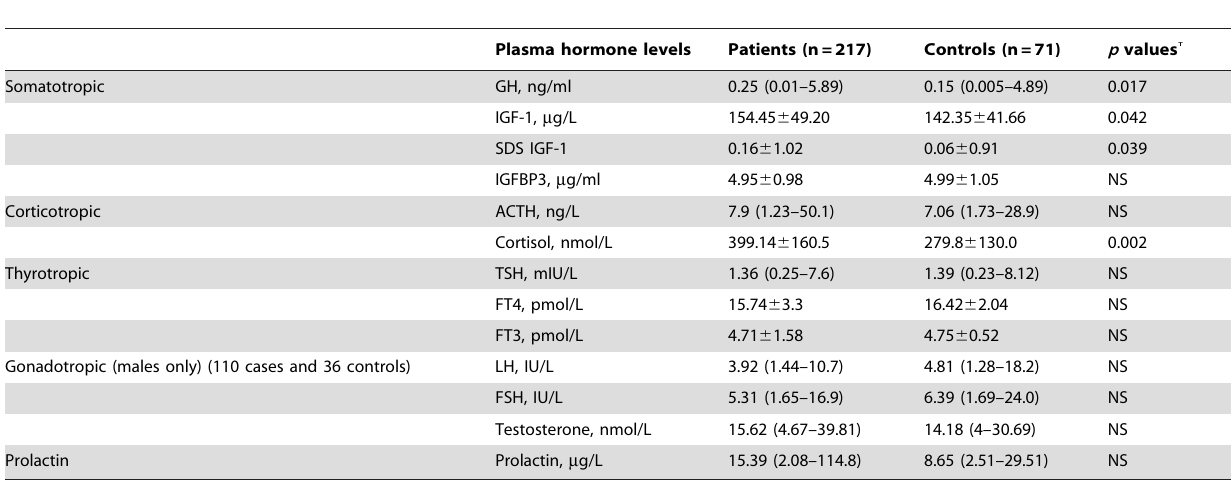
Table 2. Comparison of plasma hormone levels in patients with Huntington’s disease patients and their age- and sex-matched controls.